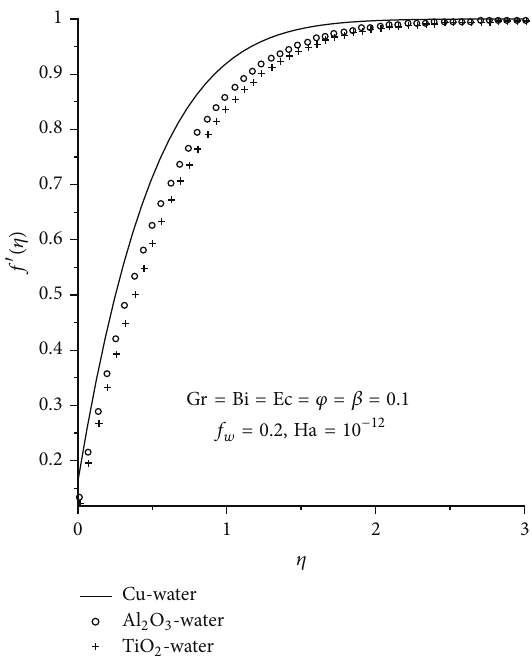
Figure 2: Velocity profiles for different nanofluids.